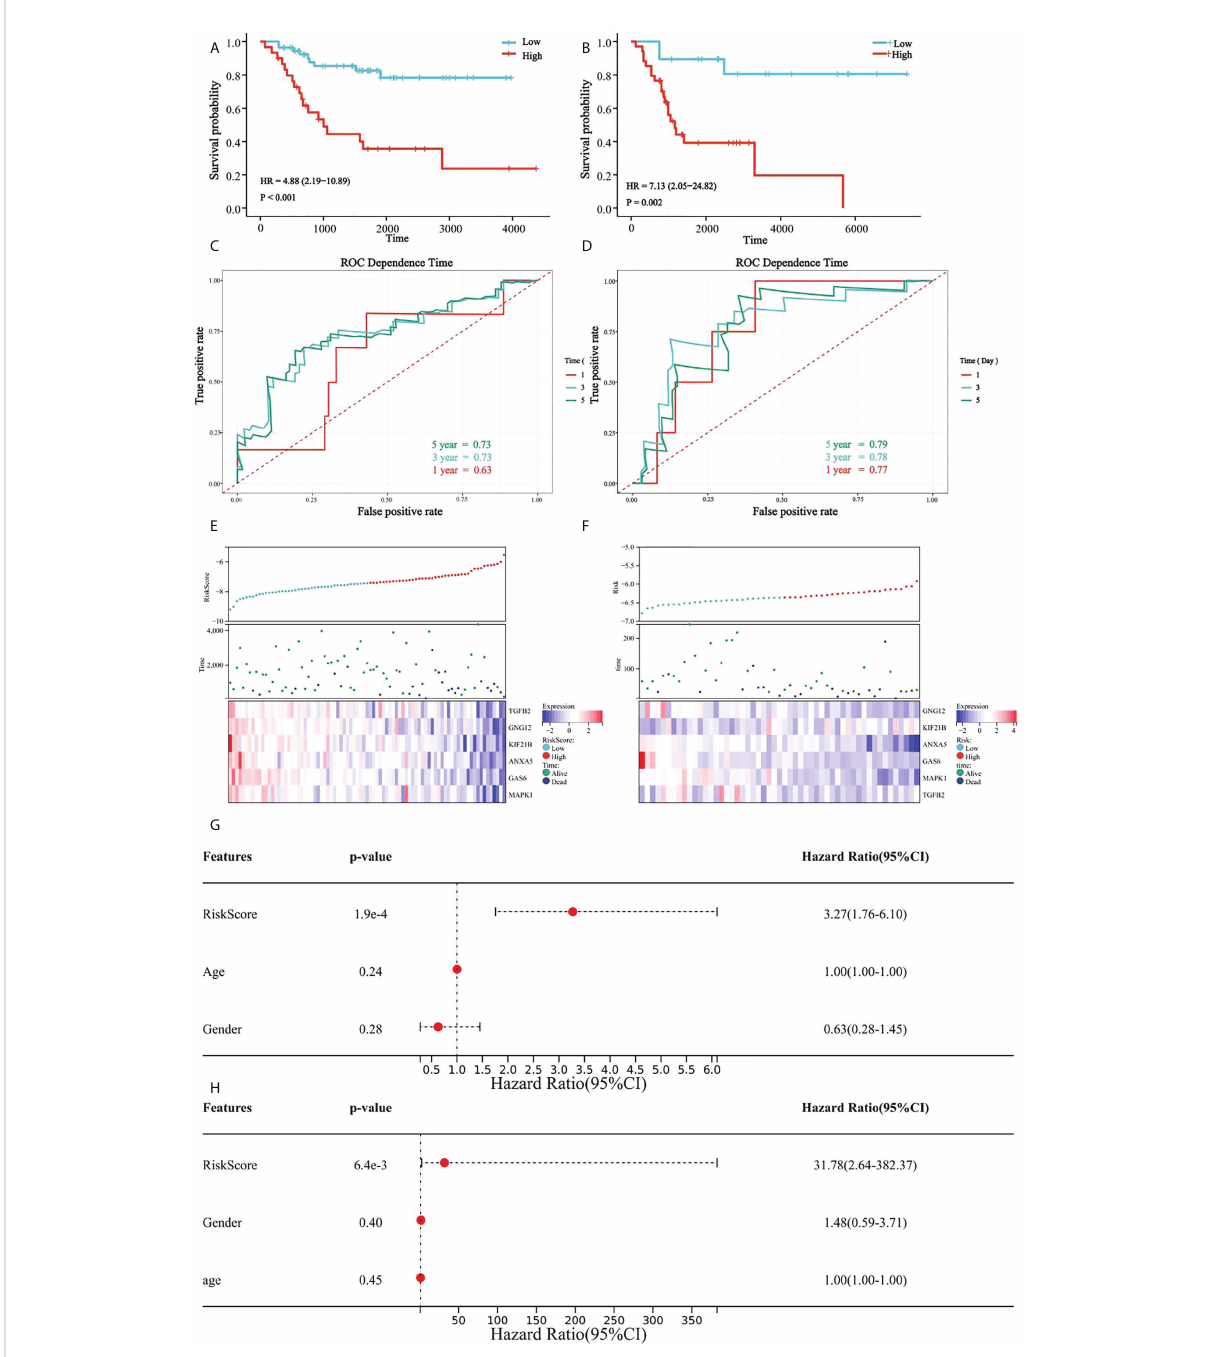
FIGURE 7 Veri fi cation of platelet score characteristics. (A) Survival difference between high-rating and low-rating groups in the TCGA cohort; (B) Survival difference between high-rating and low-rating groups in the GSE21257 cohort; (C) Time-dependent ROC analysis of TCGA cohort; (D) Time- dependent ROC analysis of the GSE21257 cohort; (E) Candidate gene expression and survival heatmap in TCGA cohort; (F) Candidate genes expression and survival heatmap in the GSE21257 cohort; (G) Forest diagram of multivariate results of platelet characteristic score model and clinical factors in TCGA cohort; and (H) Forest diagram of multivariate results of platelet characteristic score model and clinical factors in the GSE21257